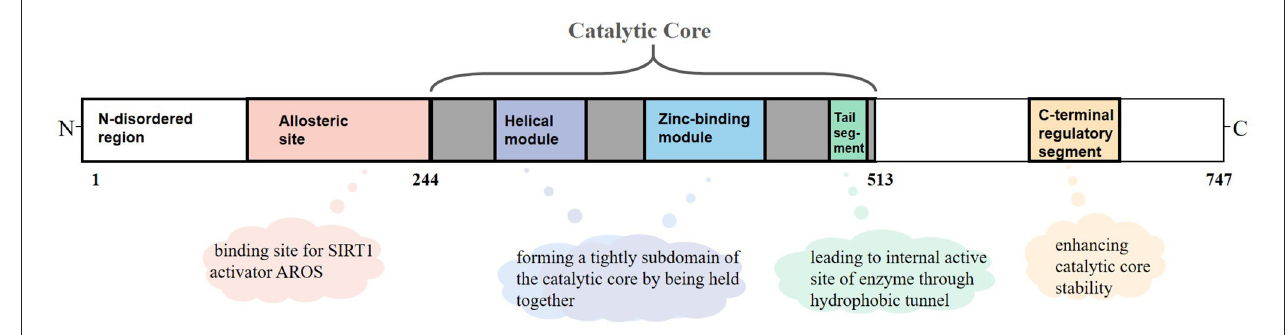
FIGURE 1 | Overview of sirtuin-1 (SIRT1) structure. SIRT1 is a monomer with 747 amino acids, which consists of a well-structured catalytic core (244–513 residues), the N-terminal (1–243 residues), and the C-terminal (513–747 residues) regions. In the catalytic core domain, the helical module and the Zn 2 + binding module are connected via an extensive hydrophobic interface. The tail segment imitates the p53 peptide sequence, binding to the internal activation site of enzyme through the hydrophobic tunnel. The allosteric site is considered as a binding site for active regulator of SIRT1 (AROS). The C-terminal regulatory (CTR) segment in disordered regions of C-terminal has a profound impact on the stability of catalytic